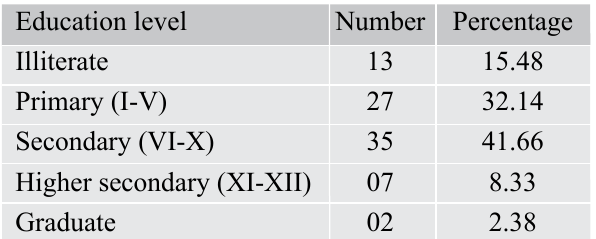
Table III: Distribution of patients according